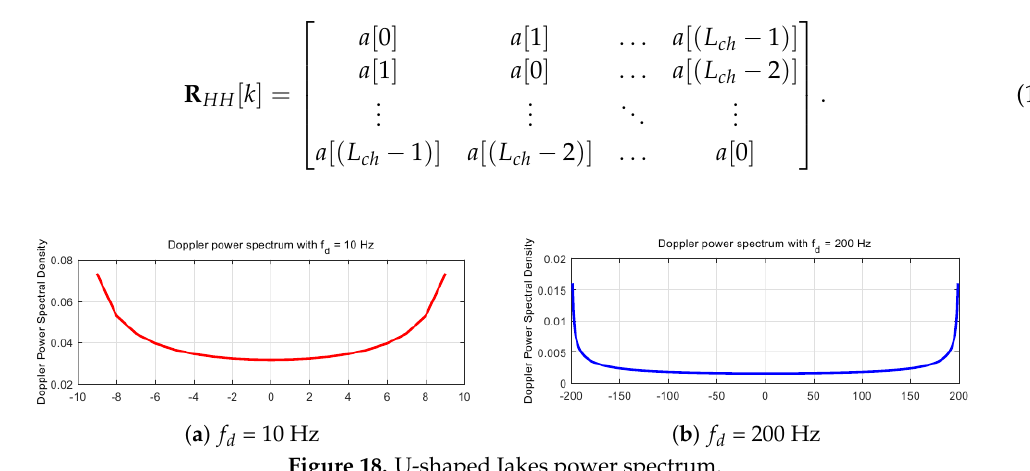
Figure 18. U-shaped Jakes power